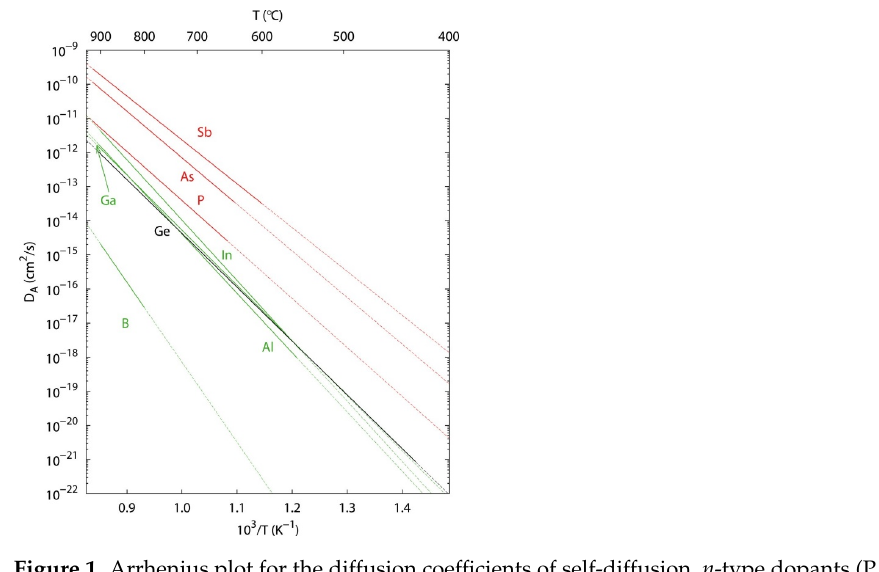
Figure 1. Arrhenius plot for the diffusion coefficients of self-diffusion, n -type dopants (P, As, Sb) and p -type dopants (B, Al, Ga, In) in Ge [59].